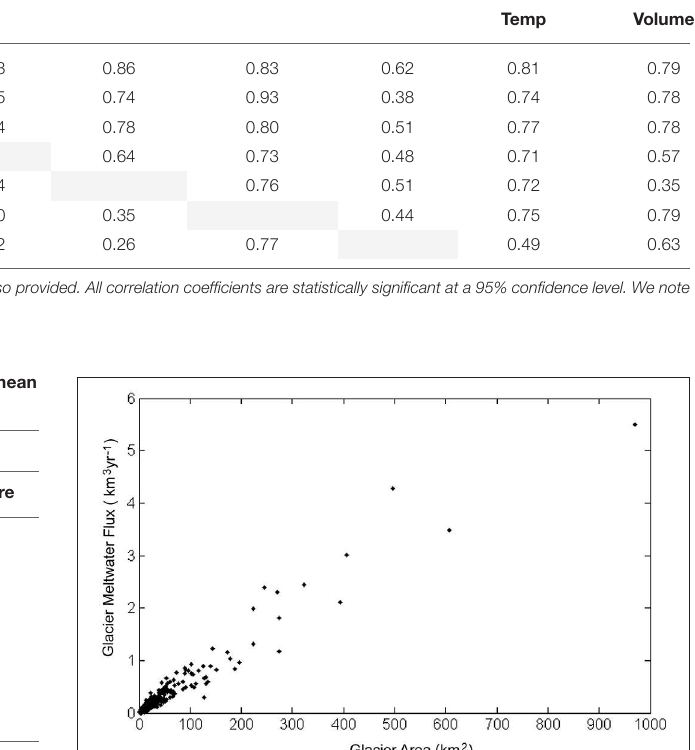
APHRO CRU ERA JMA NCEP PGMFD UD Average correlation